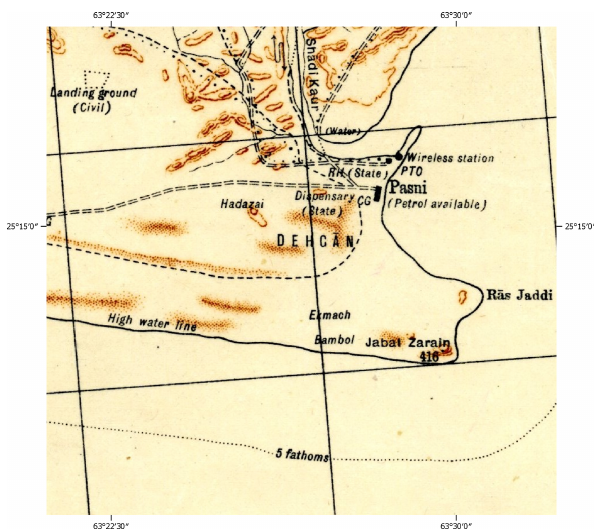
Figure 7. Old map of Pasni. An excerpt from a quarter-inch sheet by the Survey of India, G41-P Turbat, interim edition 1941, reprinted April 1943, scale 1 : 253440.